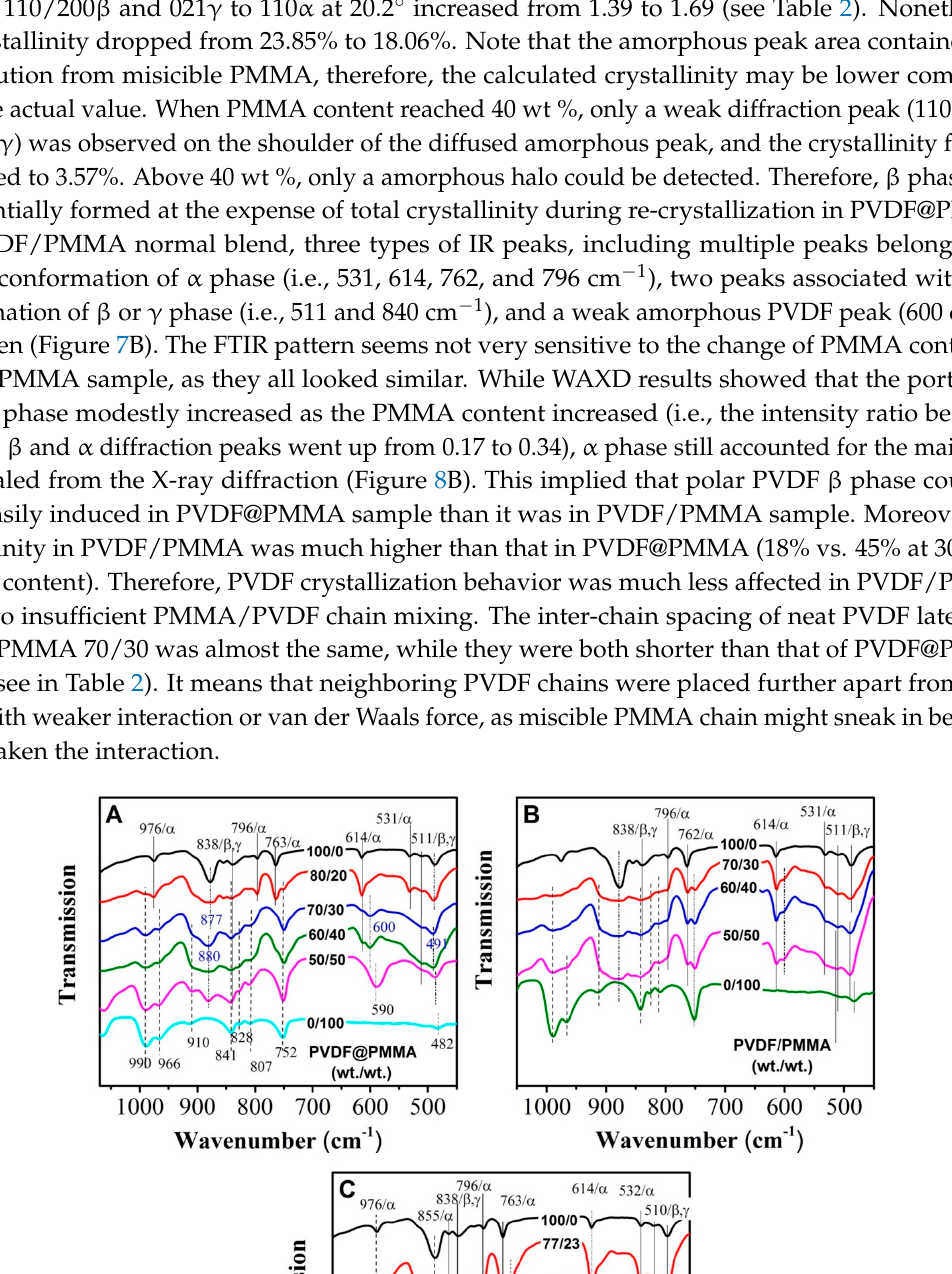
Materials, Figure S3A–L. For PVDF@PMMA sample, the percentage of polar β / γ phases among the